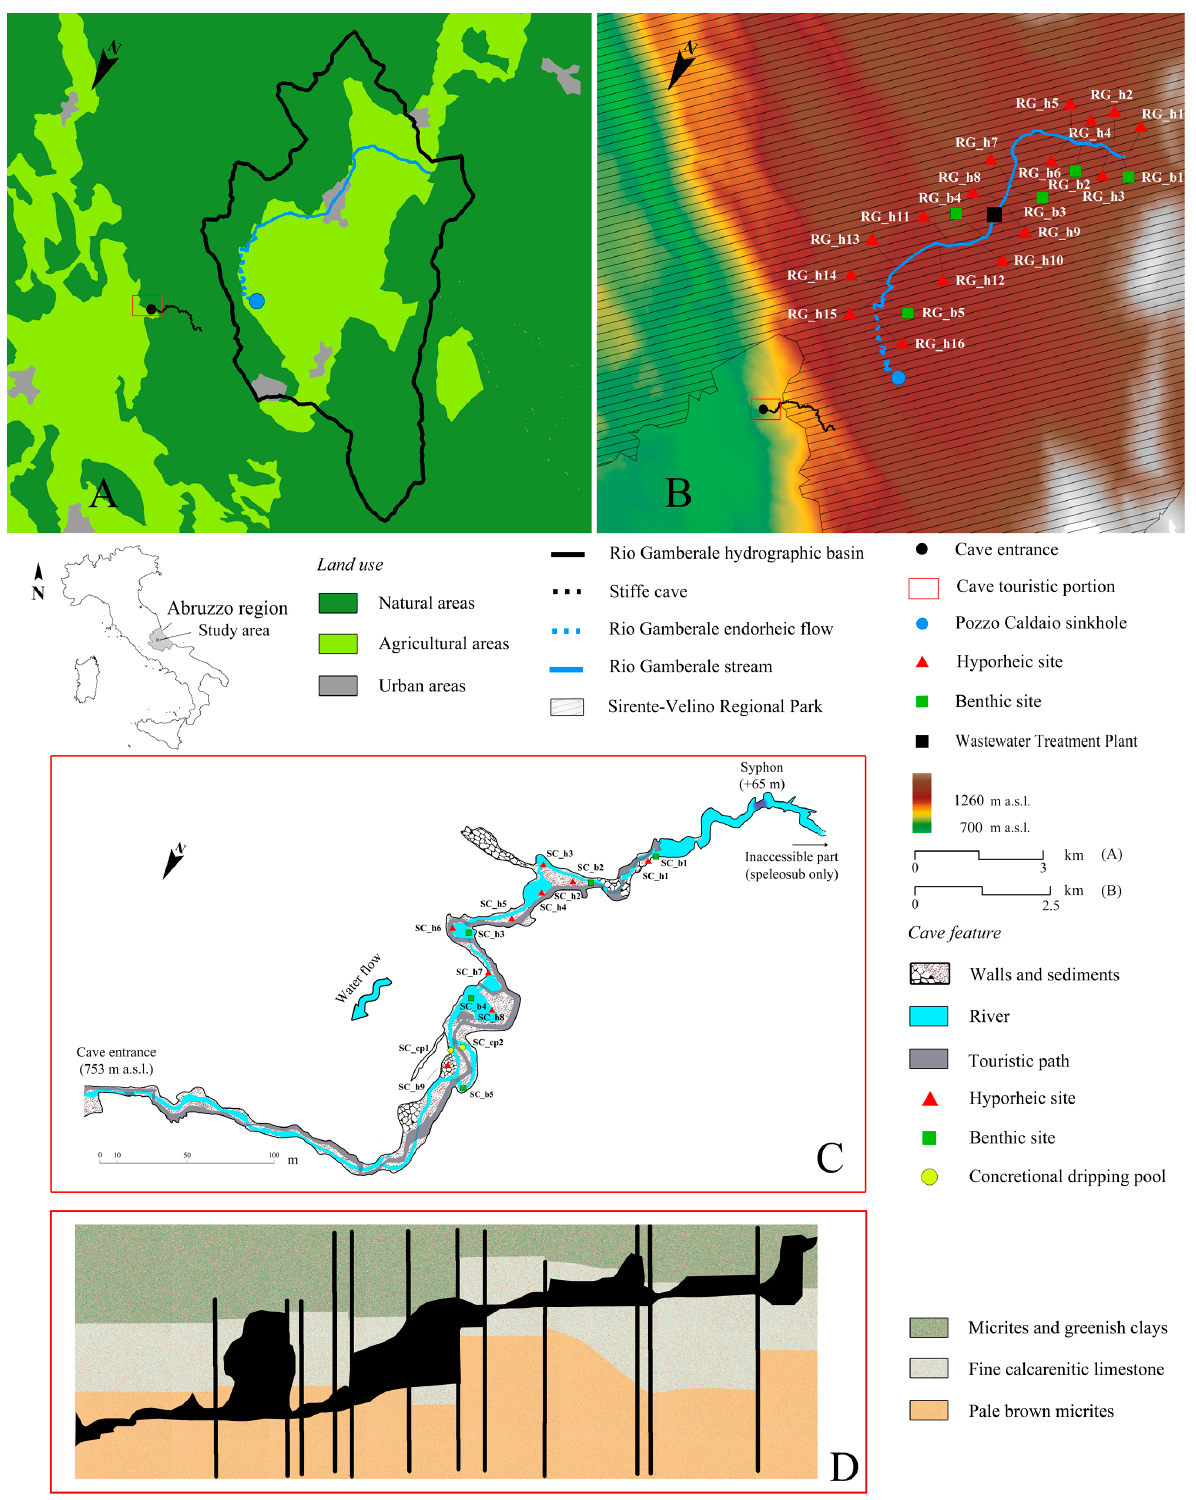
Figure 1. ( A ) Geostatistically-inferred delimitation of Rio Gamberale stream basin (solid black line), showing Rio Gamberale stream (continuous and dashed blue line) and Stiffe cave (dashed black line); ( B ) Distribution of the sampling sites along the Rio Gamberale stream; ( C ) Ground plan of the Stiffe Cave with the location of the sampling sites (Central Italy); ( D ) stratigraphic map of the touristic portion of the Stiffe cave (after Chiarelli et al., 1995 [52]; modified); black vertical lines, fault